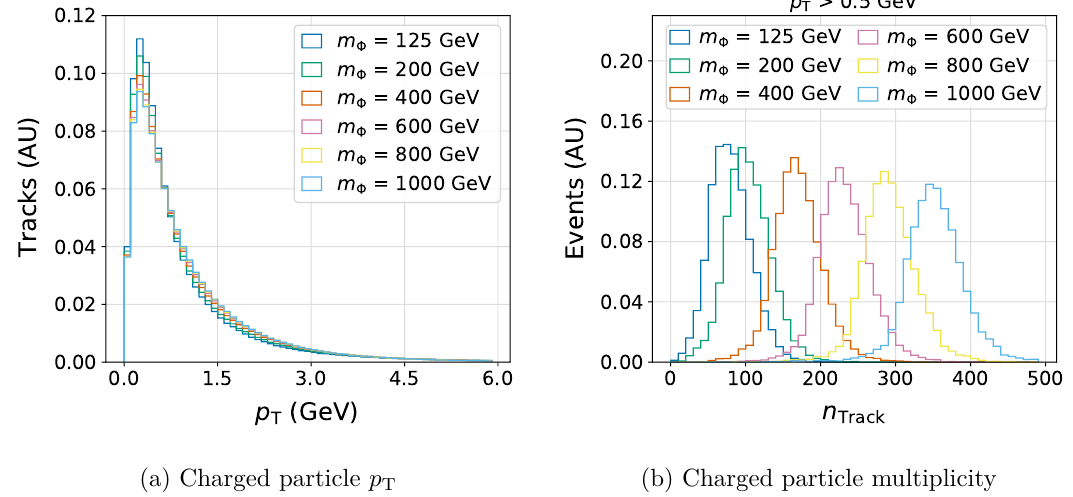
Figure 2. Distribution of all charged SM particle transverse momenta (a) and multiplicity of stable charged particles with p 0 . 5 GeV. (b) in SUEP events for a range of mediator masses. T >